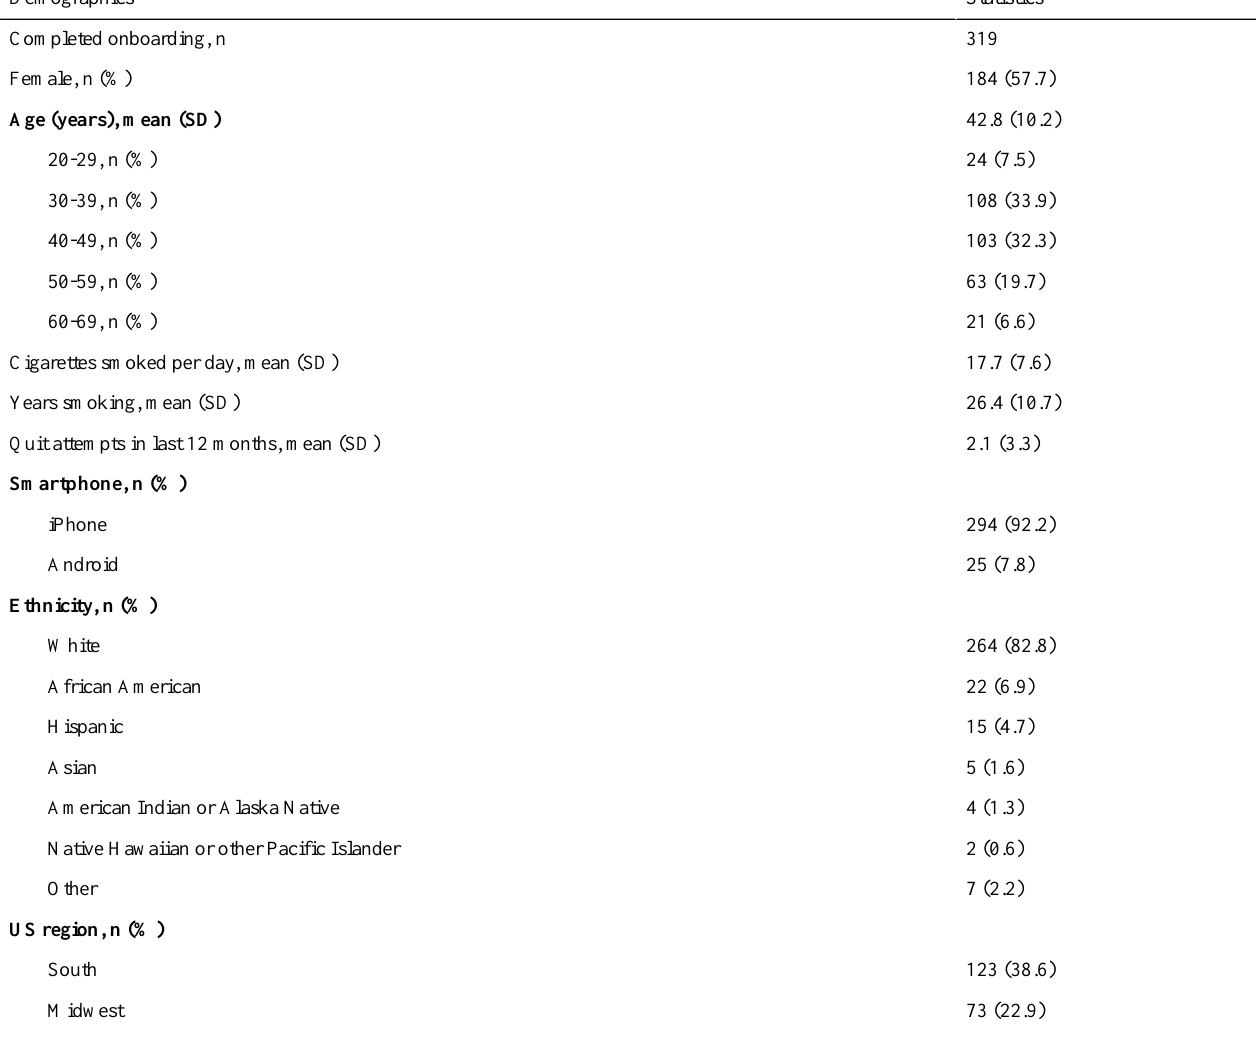
Table 3. Baseline demographics.